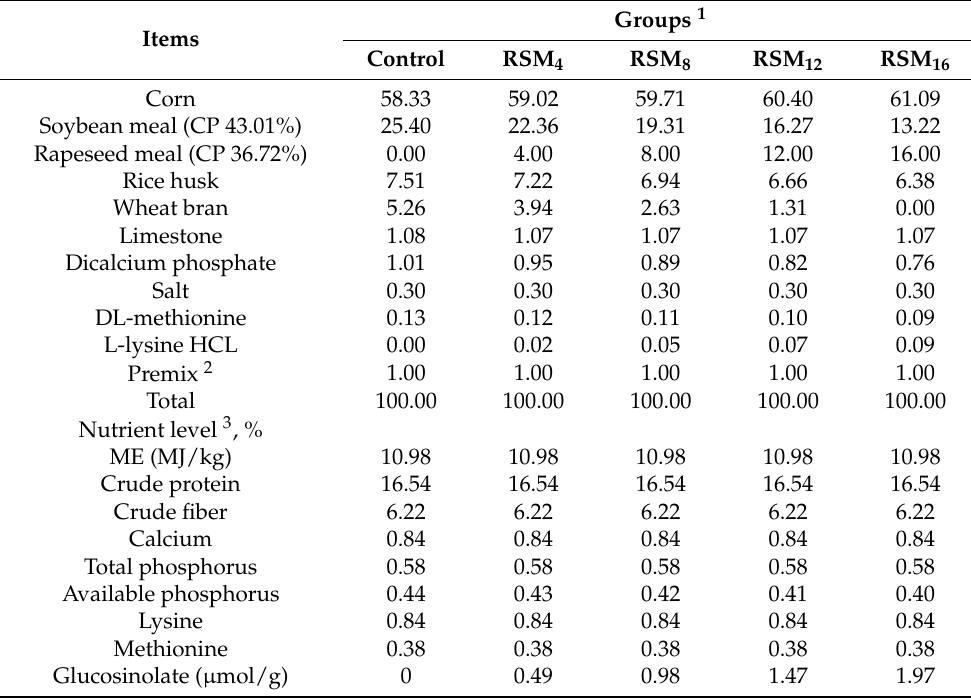
Table 2. Composition and nutrient levels of experimental diets (air-dry basis)